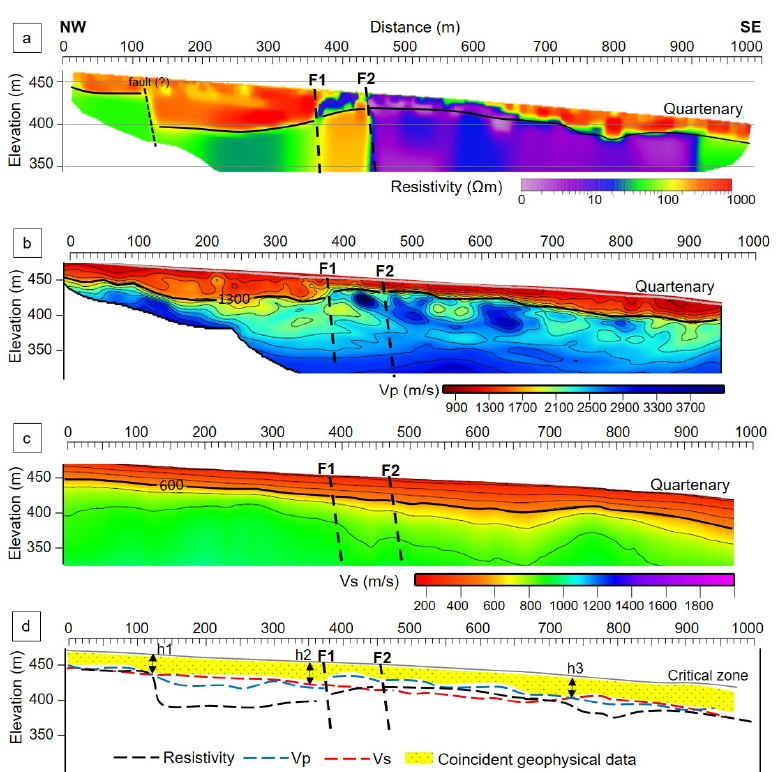
Figure 8. Geophysical imaging of La Salud North site along ~1000 m NW-SE with the interpretation proposed. ( a ) The resistivity profile, ( b ) the Vp model, ( c ) the Vs model from MASW, and ( d ) a joint comparison of the interpreted CZ. The resistivity contact marked by Figures 1 and 2 corresponds to the AMF shear zone in this sector.